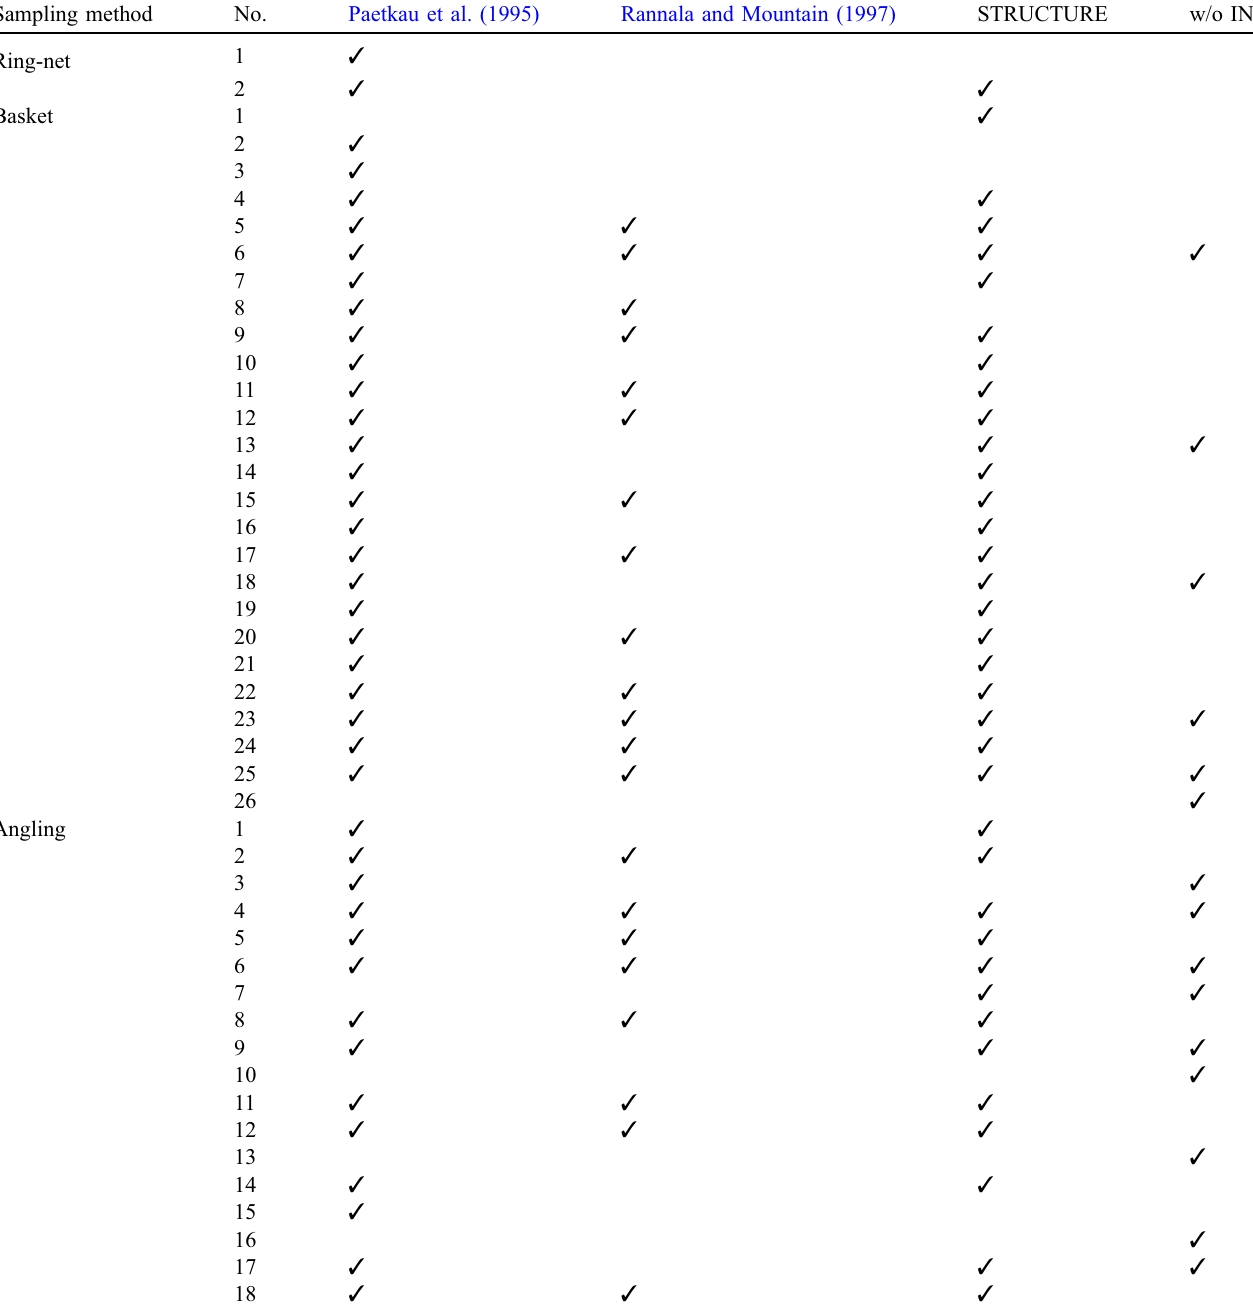
Table 5. Individuals identi fi ed as escapees by three methods of assignment and inter-nostril epidermis. Sampling